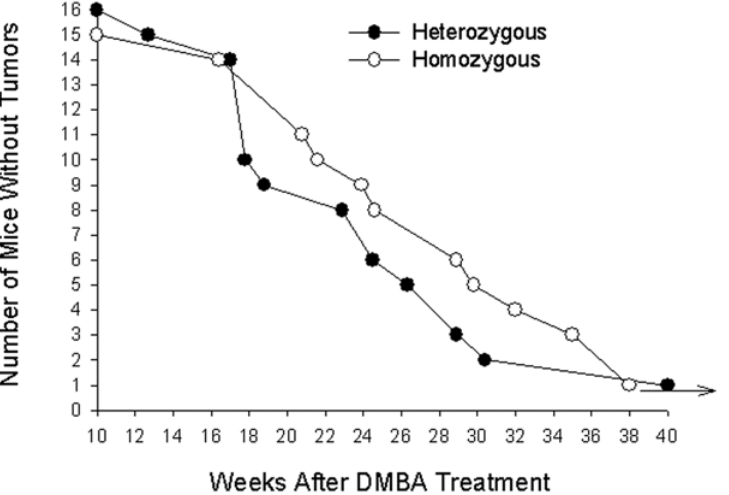
Figure 1. Tumor development. Female HTZ and HMZ PAH enu2 mice as indicated were subcutaneously implanted with a slow releasing MPA pellet at approximately 5 weeks of age, then treated with DMBA p.o. (1 mg/mouse) approximately 2 weeks later. Mice were given a total of 4 treatments of DMBA (one/week for 4 weeks). Tumor development in mice was assessed as described in Materials and Methods.